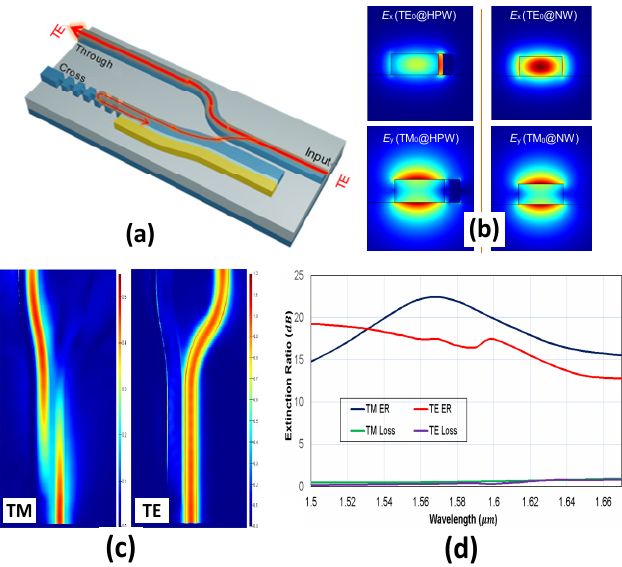
Figure 7. ( a ) Configuration of the modified ultrasmall PBS based on an ADC with a silicon hybrid nanoplasmonic waveguide; ( b ) The modal field profiles in a silicon hybrid plasmonic waveguide and an SOI nanowire; ( c ) Light propagation for TM and TM polarizations in the designed PBS; ( d ) The calculated wavelength-dependence of the designed PBS [105].